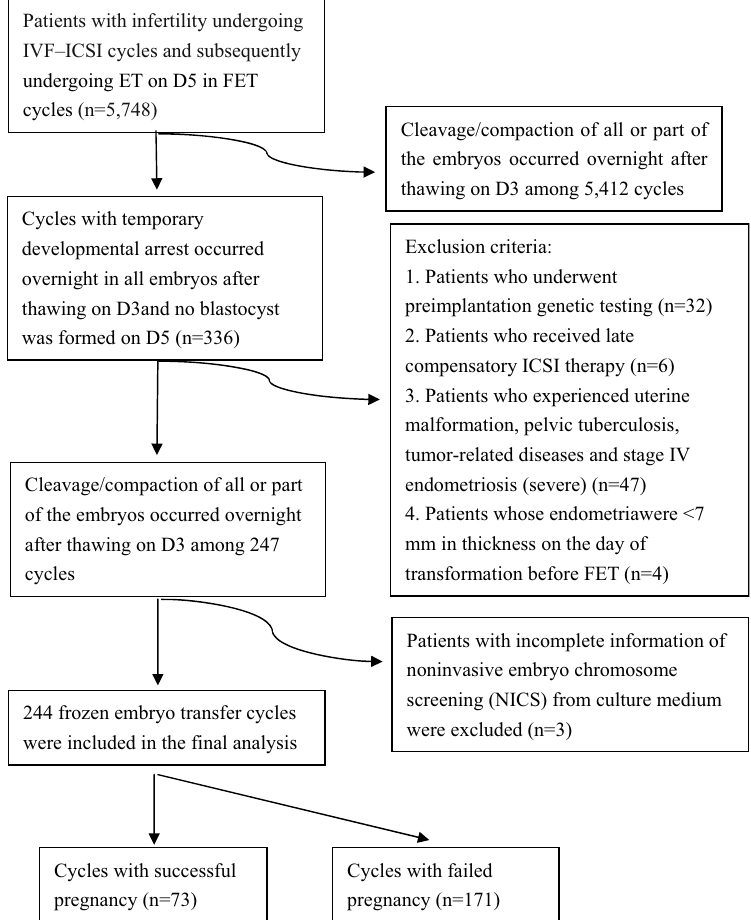
Figure 1: Flowchart showing the procedures used in selecting the study